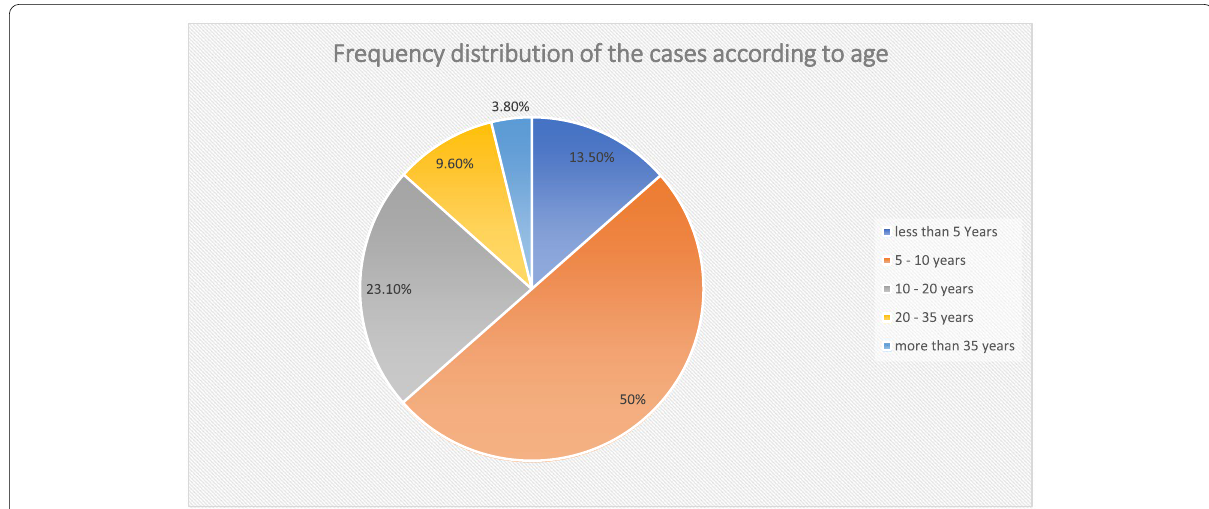
Fig. 1 Frequency distribution of the cases according to